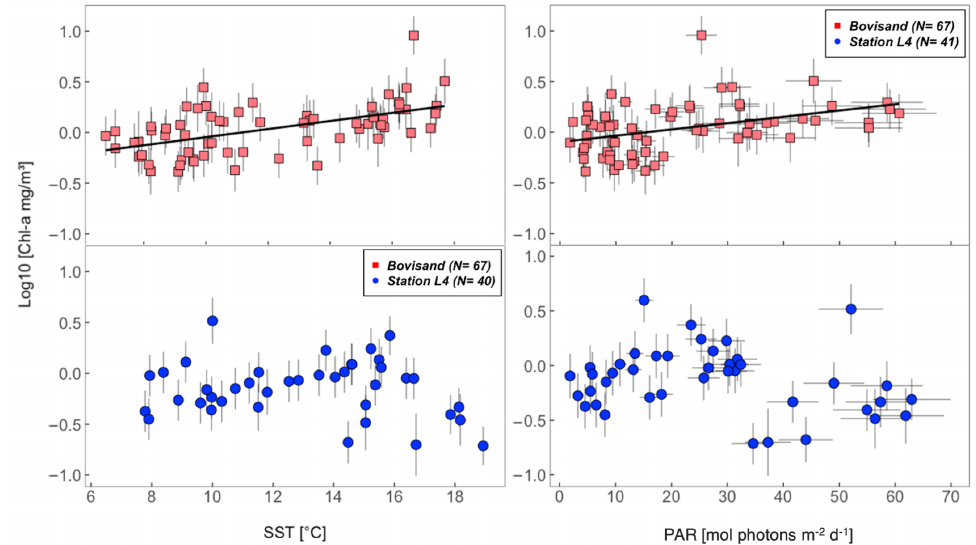
Figure 9. Scatter plots of chl- a against physical variables (SST and PAR) at Bovisand (red squares) and Station L4 (blue circles). Error bars (vertical and horizontal) represent the measurement uncertainty for both the explanatory (SST and PAR) and response (chl- a ) variables. Ordinary least squares (OLS) regression line is not plotted in the L4 plots due to their non-significance (Table 1: p -values >